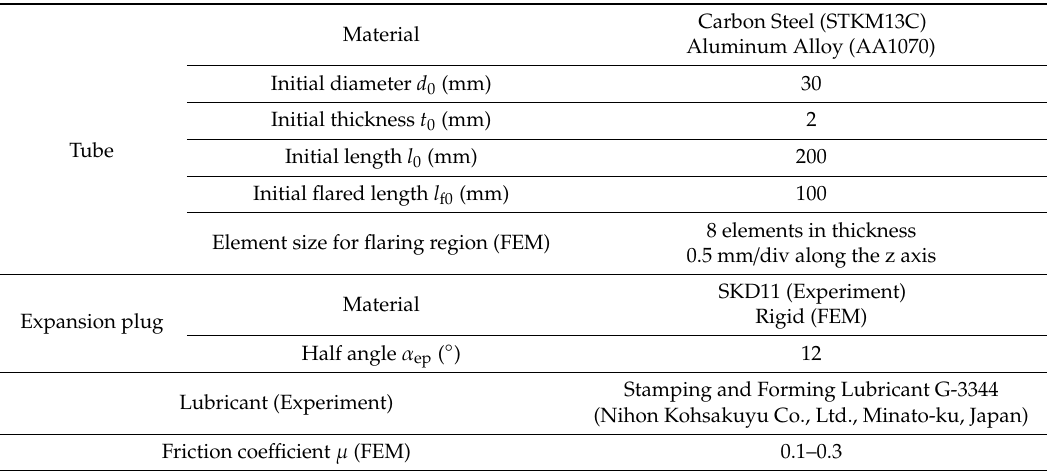
Figure 4. Two-dimensional implicit model for flaring (FL-2D-Impl) for FEM analysis. Table 1. Process conditions for tube flaring. Table 1. Process conditions for tube flaring.